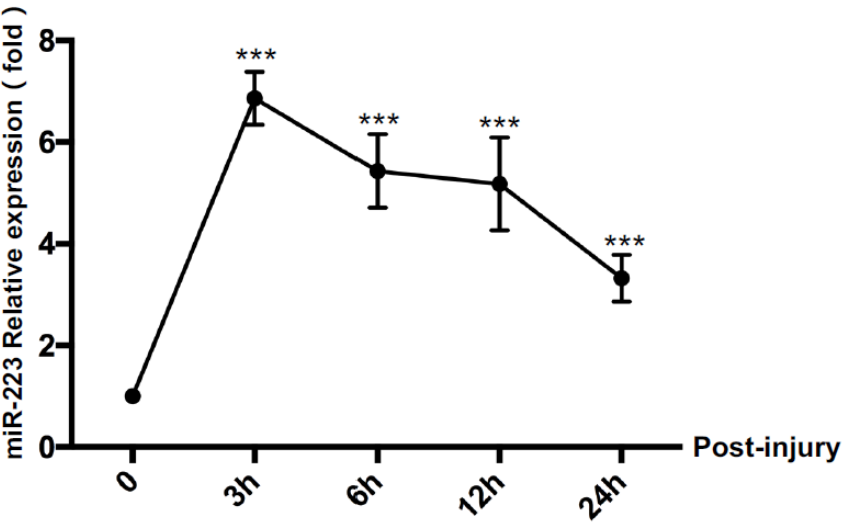
Figure 1. The altered miR-223 level in bEnd.3 cells after SI. The level of miR-223 increased significantly at 3 h, 6 h, 12 h, and 48 h post-injury compared with that at 0 h. n = 6 per group; data are presented as mean ± SD; *** p < 0.001. miR-223: microRNA-223; SI: stretch injury; bEnd.3: brain-derived endothelial cells. 3; h: hour.